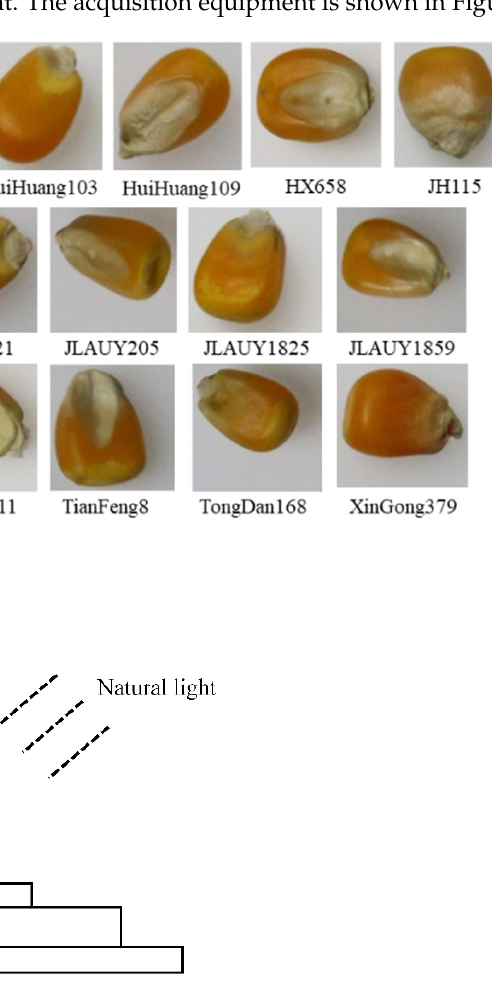
Figure 2. Corn seed image acquisition system.